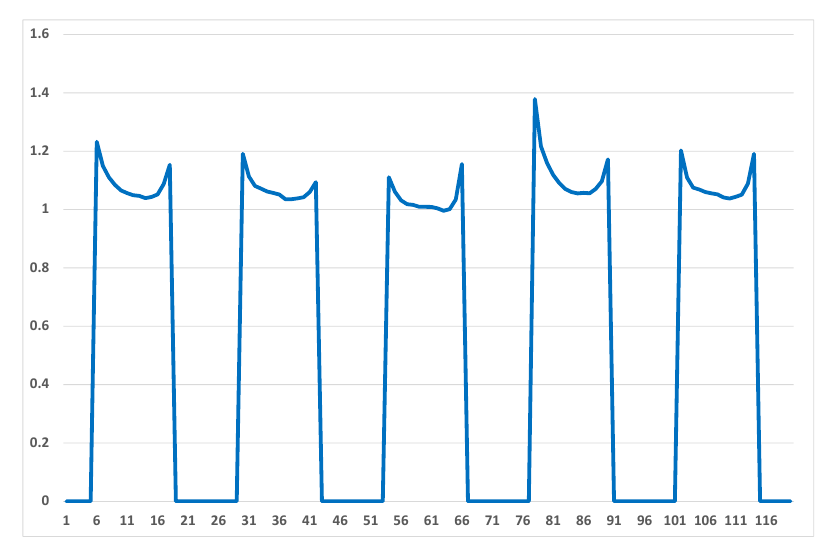
Figure 11. Histogram of CSI values for Los Vegas.